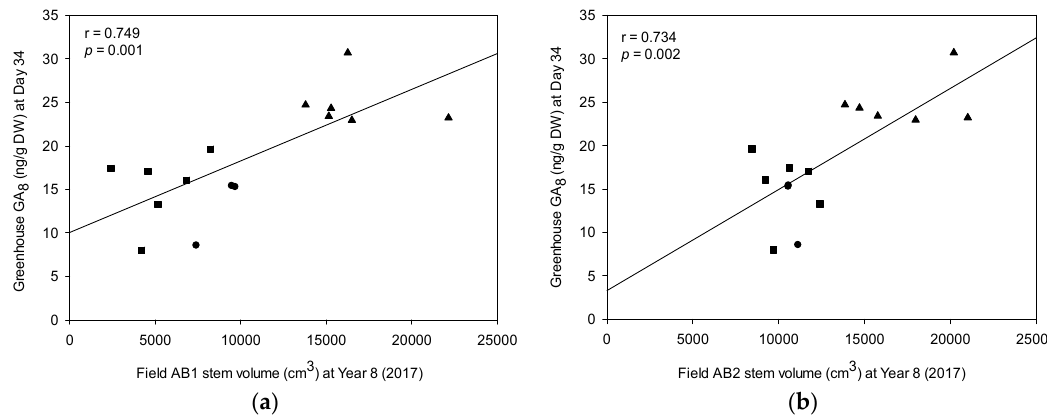
Figure 8. Pearson’s correlation (r) between greenhouse GA 8 (ng/g DW) at Day 34 (after transplanting) and field stem volume for 15 selected progeny; ( a ) Field AB1, AB; and ( b ) Field AB2, AB. Symbols represent individual progeny that had been previously grouped with FG ( ▲ ), SFG ( ■ ), and SG ( ● ). Note: SG = slow-growing progeny; SFG = slow-growing progeny from a fast-growing family; and FG = fast-growing progeny.